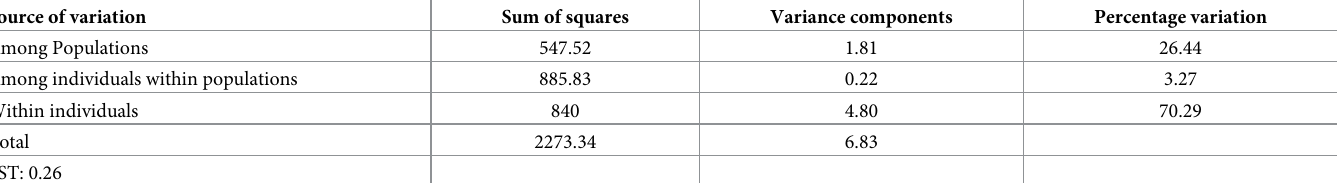
Table 2. Groupings for the Analysis of Molecular Variance (AMOVA) for Lates niloticus at 19 microsatelite loci. Source of